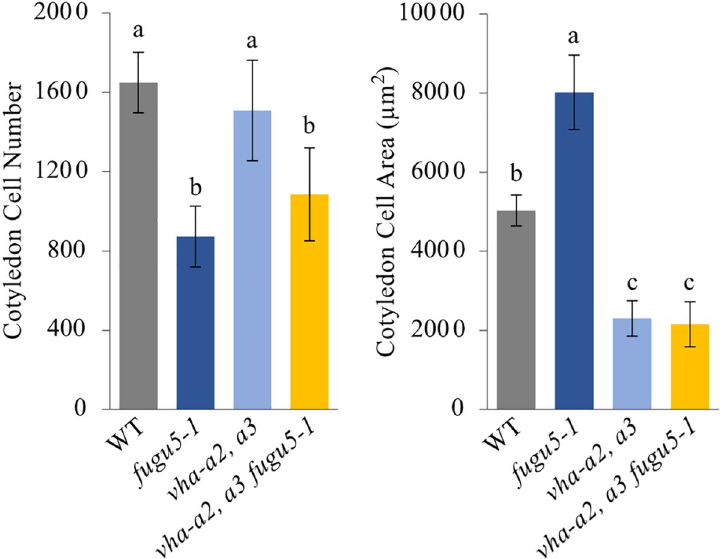
Fig 7. V-ATPase Complex Activity is Essential for Compensated Cell Enlargement in fugu5 . Effect of suppressed V-ATPase activity on CCE. Cotyledons of the WT, fugu5–1 , and vha-a2 vha-a3 ( vha-a2 , a3 ) double mutants, and vha- a2 vha-a3 fugu5-1 ( vha-a2 , a3 fugu5-1 ) triple mutants were dissected from plants grown on rockwool for 25 DAS, fixed in FAA, and cleared for microscopic observations. Data represent cotyledon cell numbers and cotyledon cell areas. Data are means ± SD (n = 8 cotyledons). Letters indicate groups (Tukey’s HSD test at P < 0.05; R version 3.5.1). DAS, days after